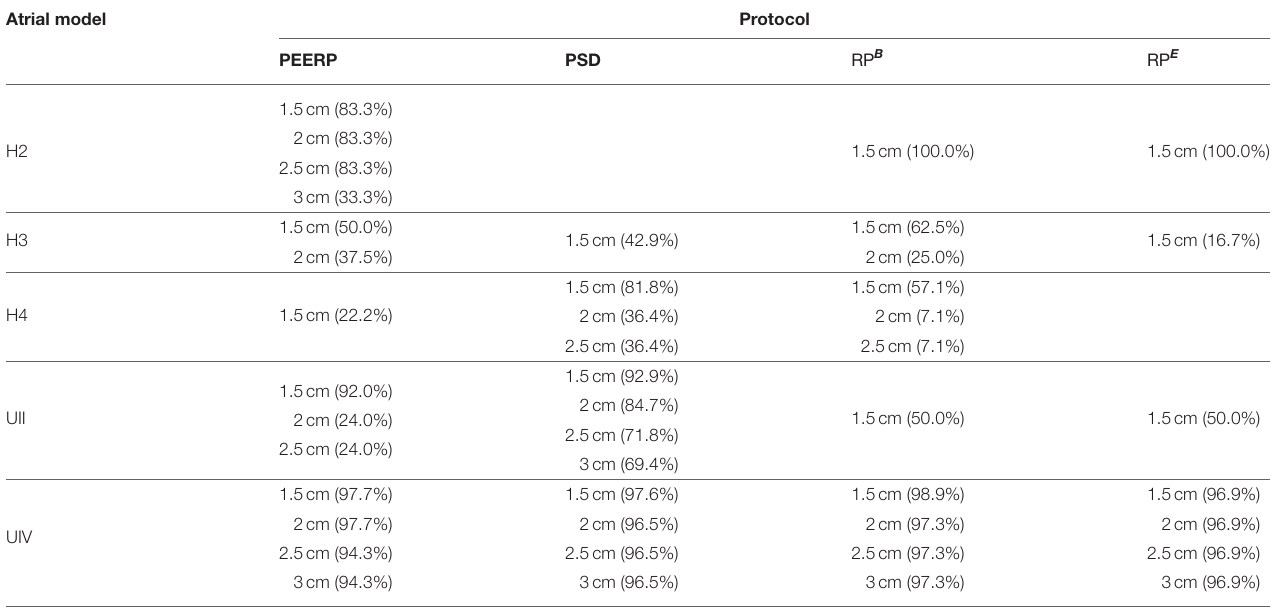
TABLE 1 | Sensitivity of each protocol in the different atrial models to increased inter-point distance. Atrial model